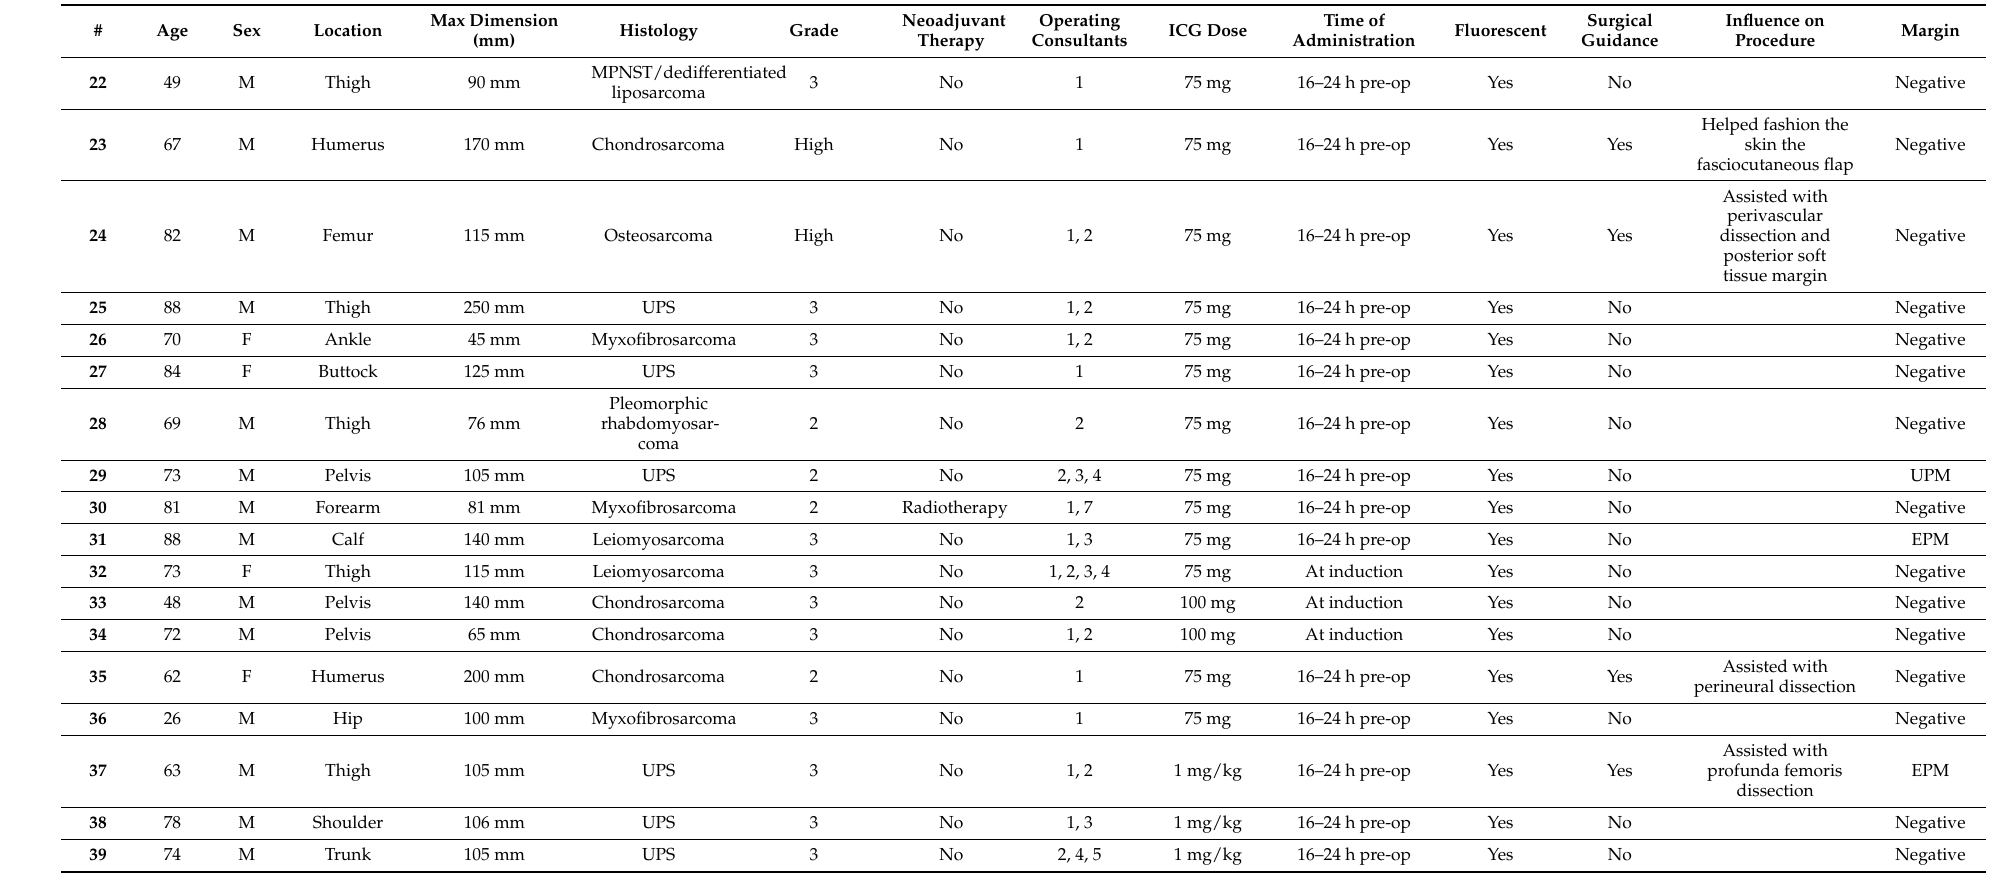
EPM = expected positive margin, UPM = unexpected positive